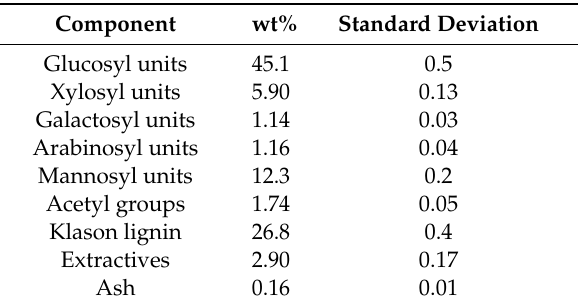
Table 1. Composition of the Pinus pinaster wood lot employed in this study. Data expressed as weight percent, on an oven-dry wood